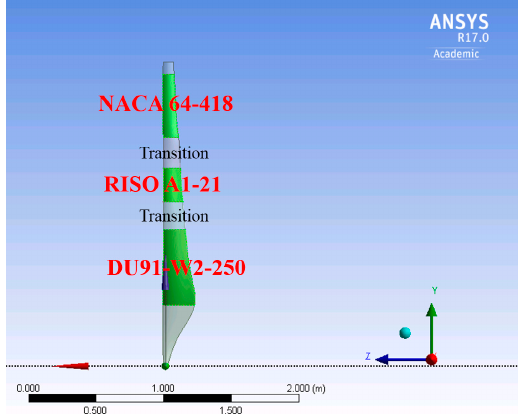
Figure 2. MEXICO rotor geometry, a three ‐ bladed rotor with 4.5 m diameter. Reference for the blade geometry data: Scheppers et al.